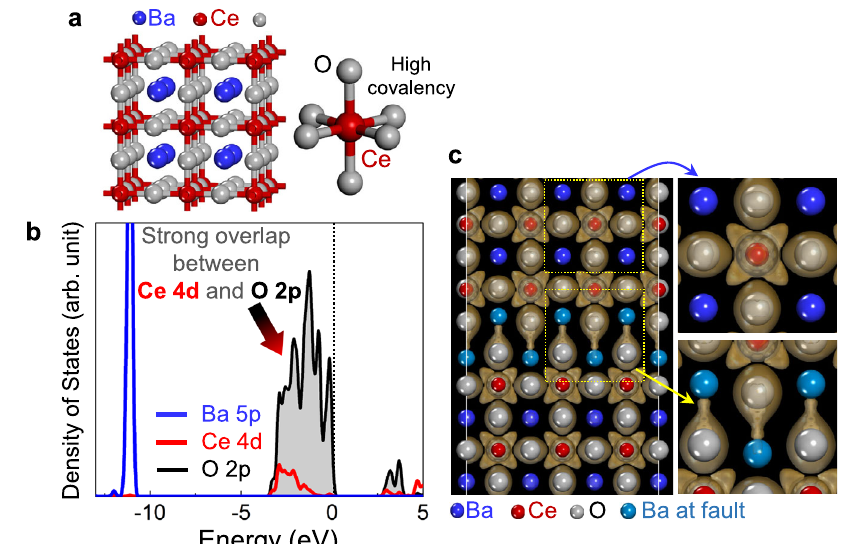
Fig. 2 | Bond characteristics at RP faults in BaCeO 3 . a The crystal structure of BaCeO 3 is presented. b This DOS plot indicates a strong overlap between the O 2 p and Ce 4 d states in contrast to no overlap of the Ba 5 p states with the electronic statesofoxygenbelowtheFermilevel.Consequently,ahighdegreeofcovalencyin Ce − O bonding is represented. c In good agreement with the DOS plot, A high